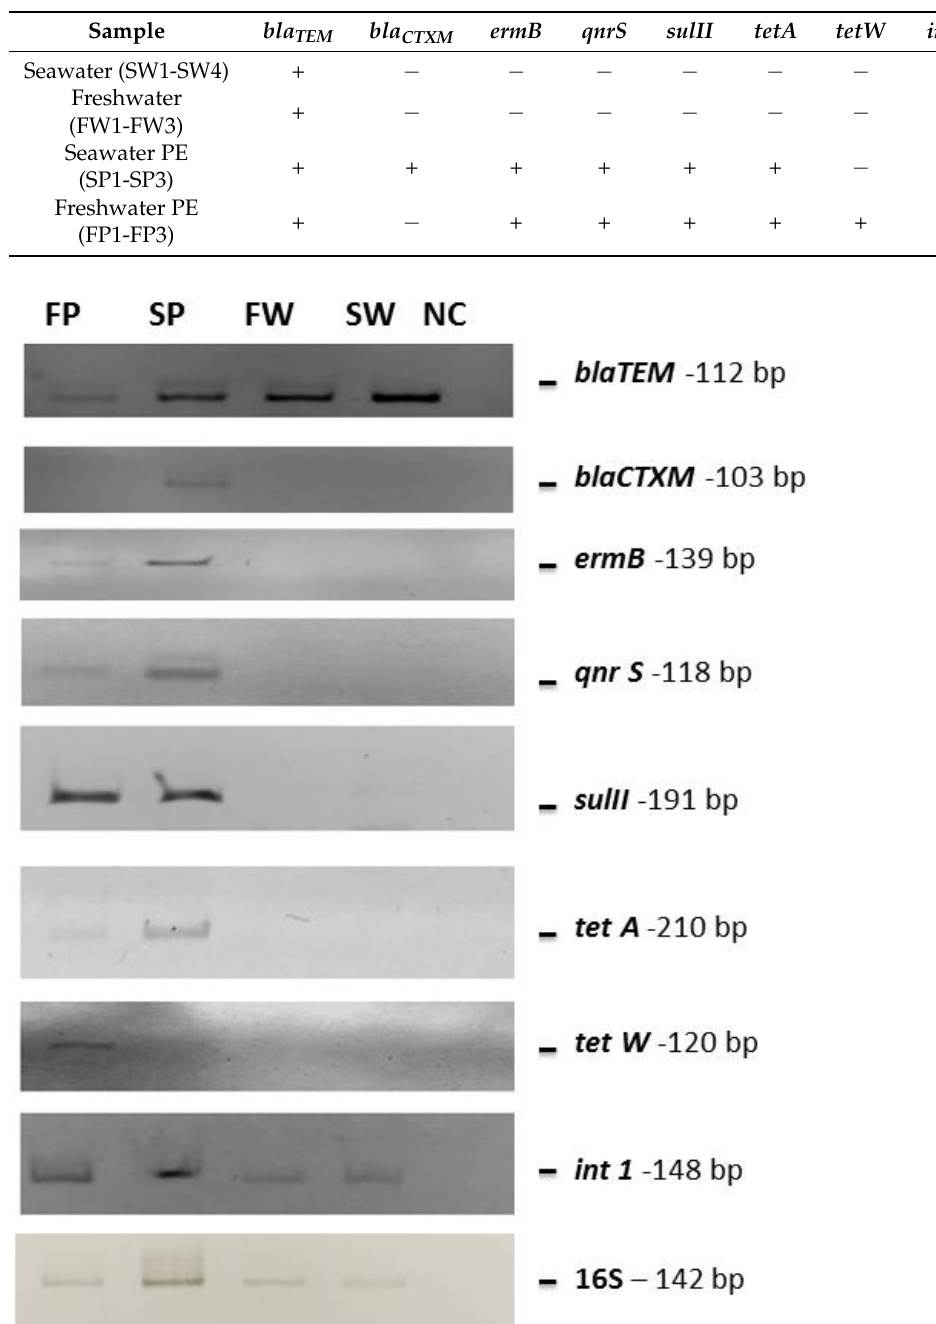
Table 6. Summary of the presence/absence of ARGs and int1 gene detected in metagenomics DNA samples extracted from water and PE waste collected from freshwater and seawater.